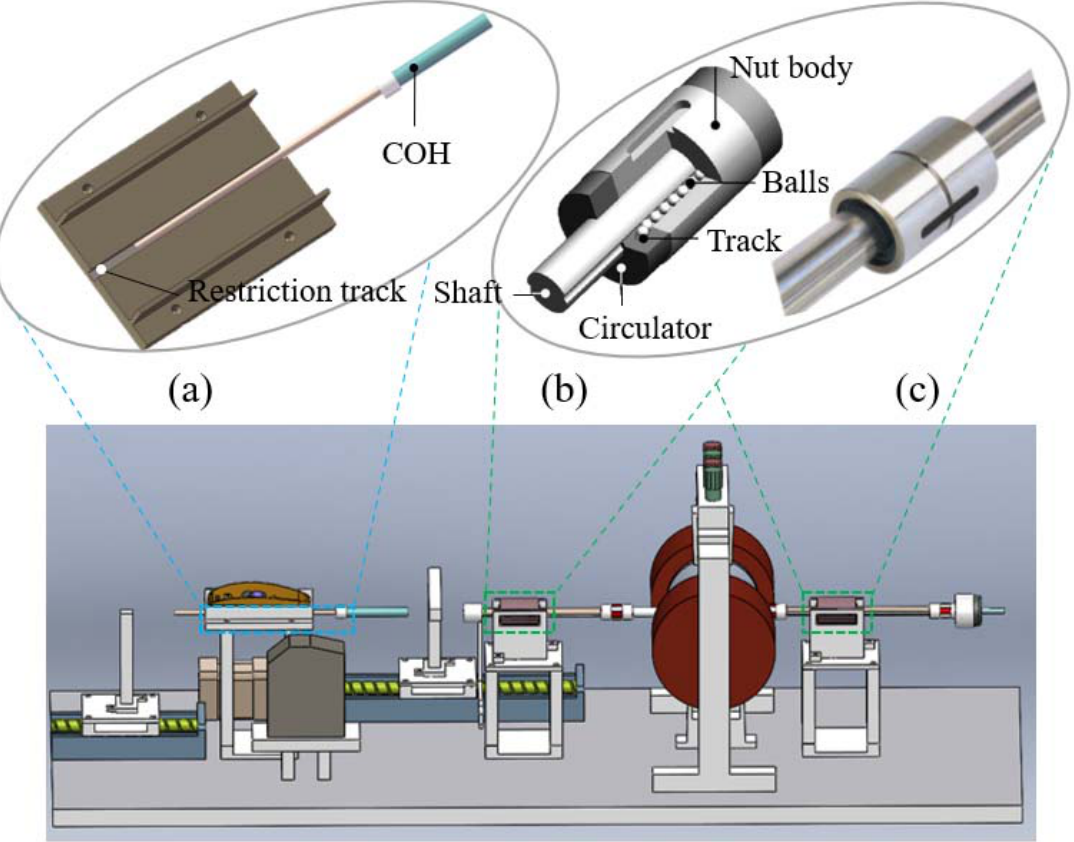
Figure 8. Structural design of operating tremor reduction in the master haptic device: ( a ) restriction track for COH; ( b ) structure diagram of ball spline; ( c ) actual picture of ball spline.